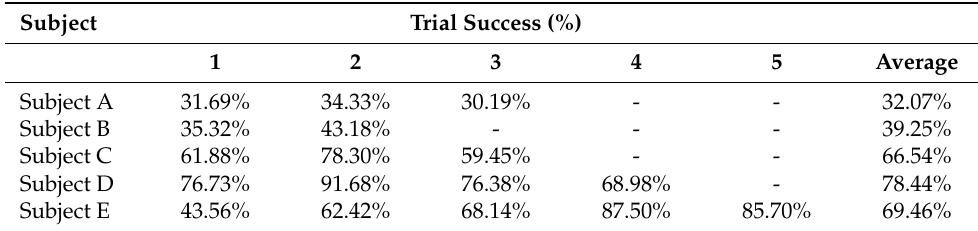
Table 4. Success rate comparison between subjects.